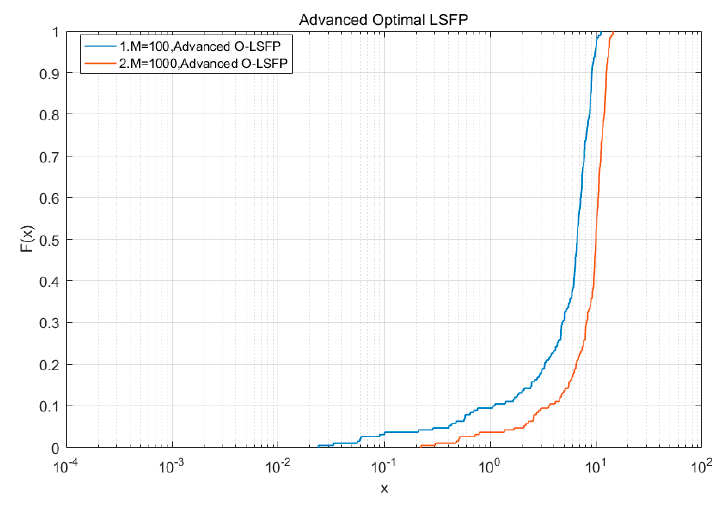
Figure 7. CDF of A-O-LSFP channel can achieve.